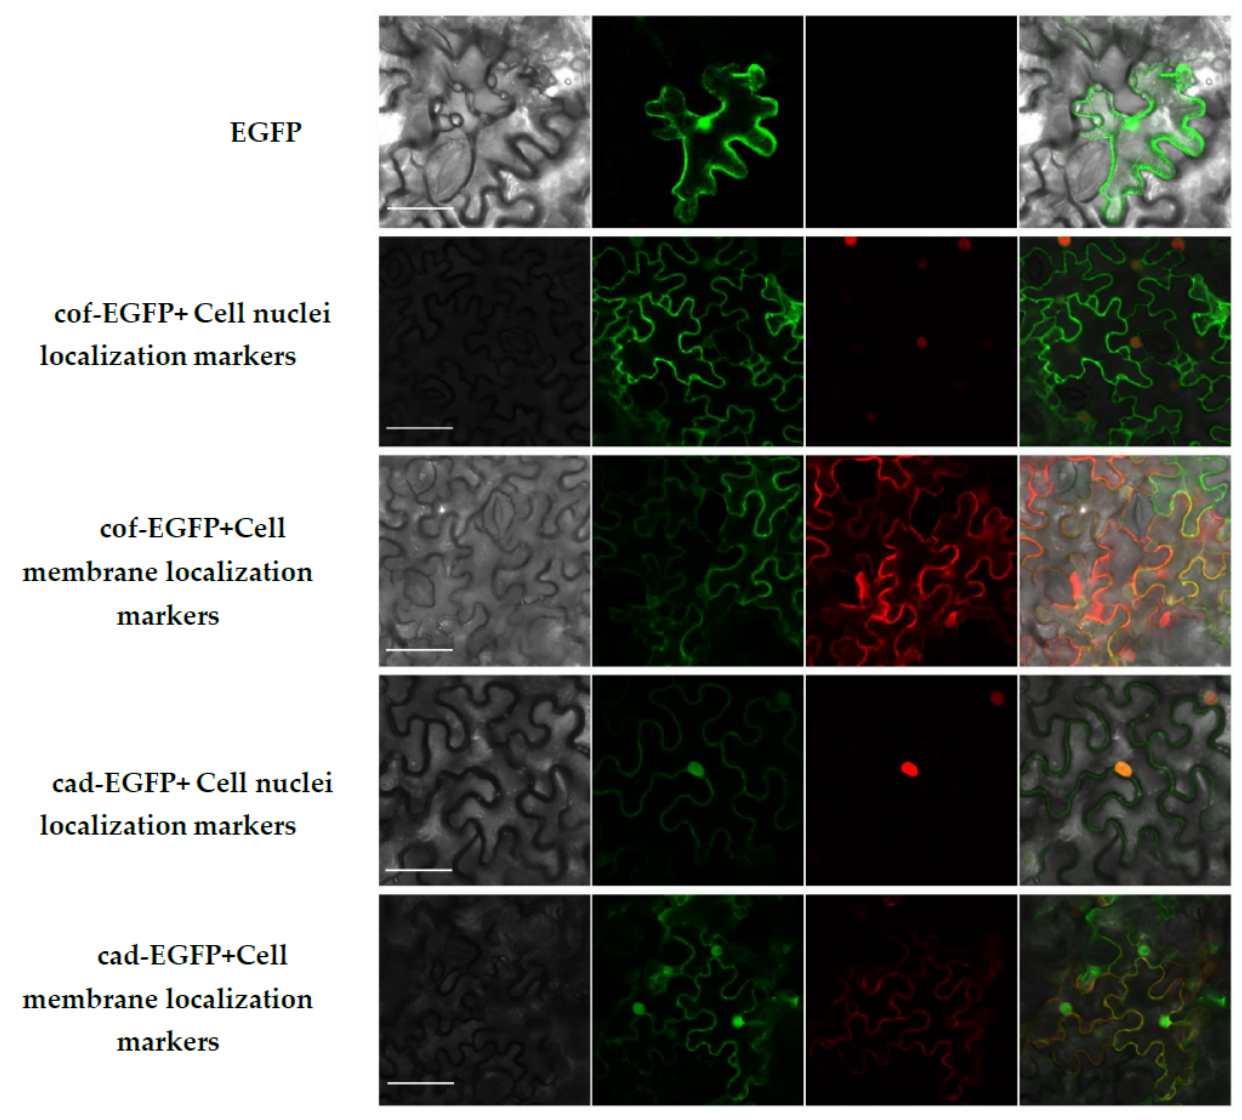
Figure 9. CCoAOMT2 and CAD5 subcellular localization. The white bar indicates 50 μ